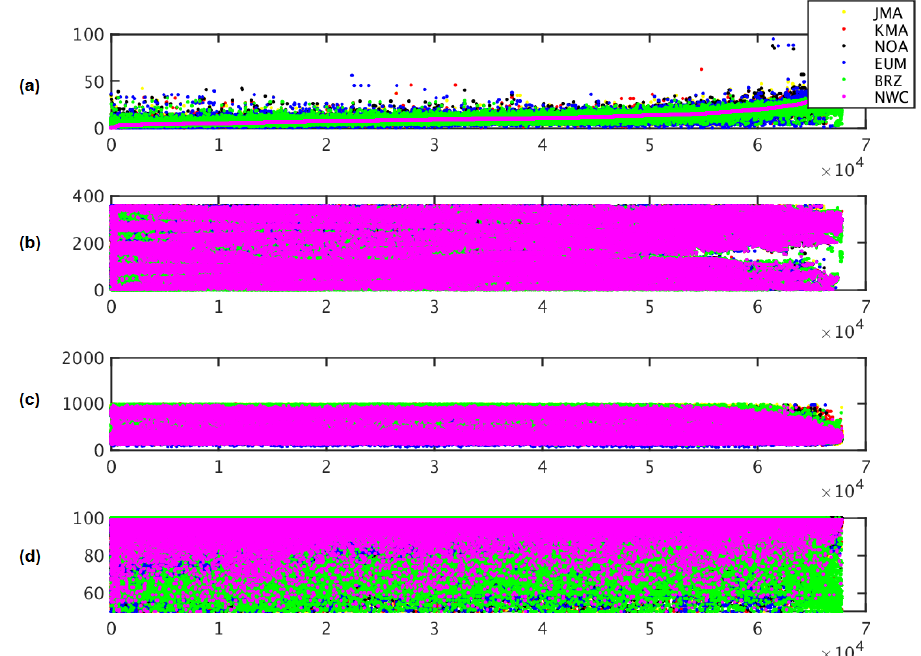
Figure 7. ‘ Parameter plot’ for collocated AMVs from the different AMV datasets in Experiment 2, with CQI >= 50% and a collocation distance up to 55 km. Considered variables are speed ( a ), direction ( b ), pressure ( c ), and CQI ( d ). Color codes correspond to BRZ in green, EUM in blue, JMA in yellow, KMA in red, NOA in black, NWC in magenta.